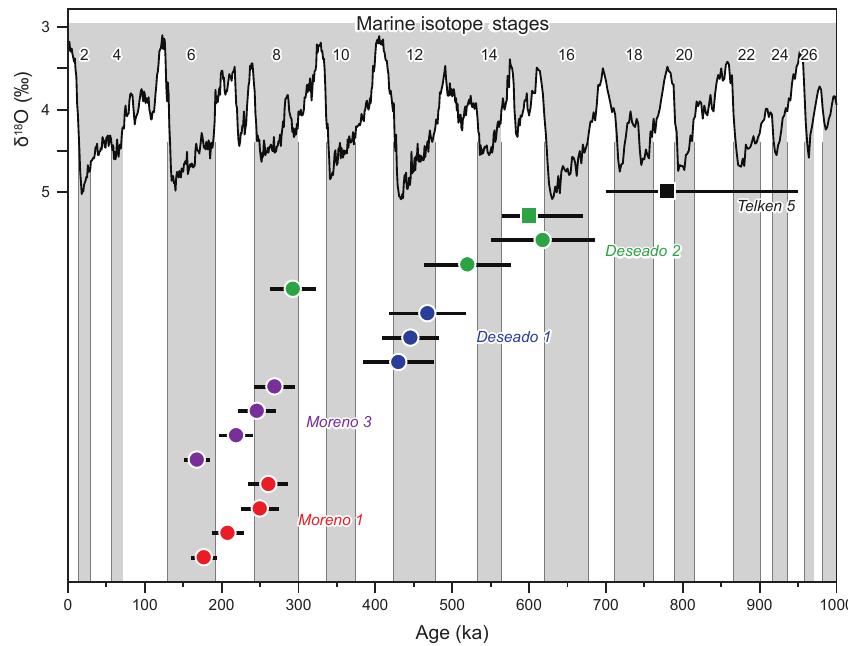
Figure 2. 10 Be exposure ages from outwash surface cobbles (circles) and modeled depth profiles (squares) for five of the Lago Buenos Aires moraines. Depth profile uncertainties are 1 σ . Symbols and colors are the same as in Fig. 1. The δ 18 O benthic stack record from Lisiecki and Raymo (2005) is also plotted, and gray shading shows glacial